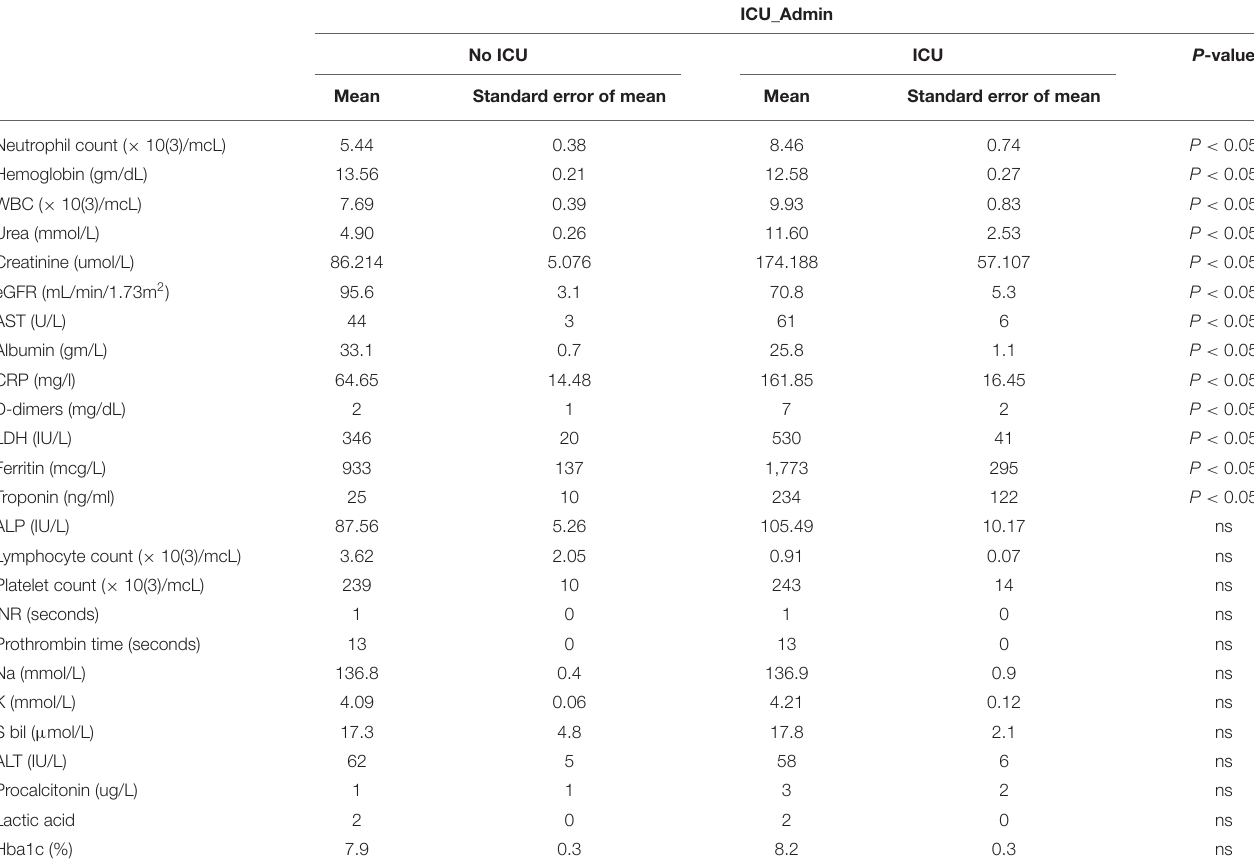
TABLE 3 | Laboratory parameters in the training cohort.